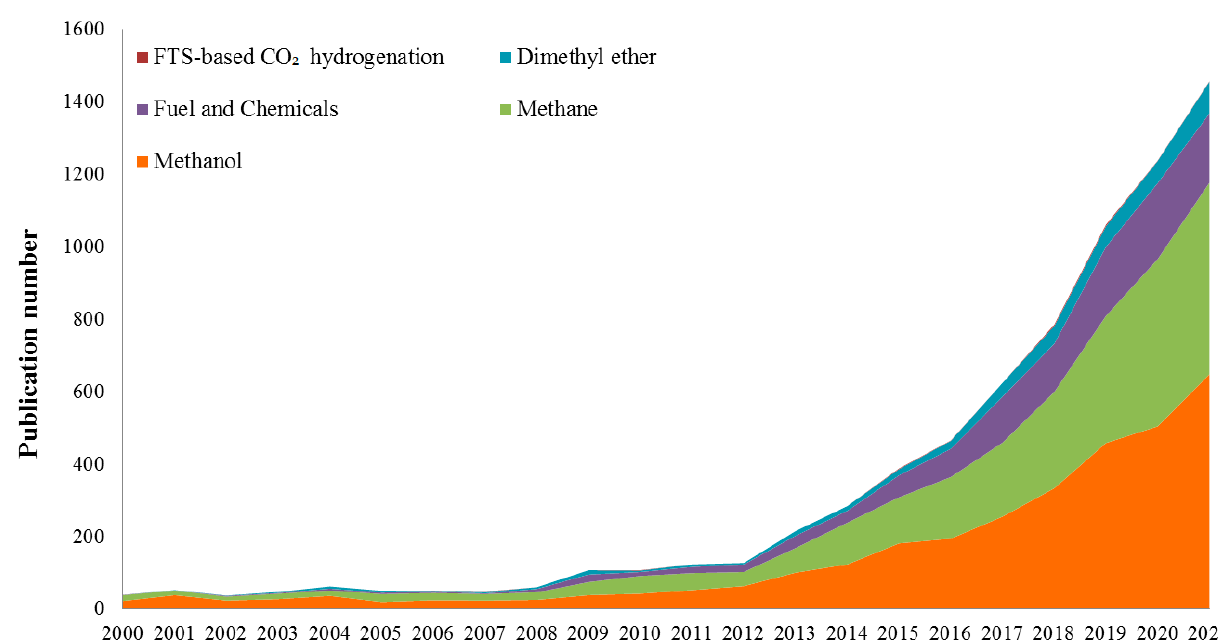
Figure 15. Number of publications found in the Web of Science database using keywords related to CO 2 transformation in various products from 2000 to 2022. Publications include research articles, reviews, patents, books, and letters.